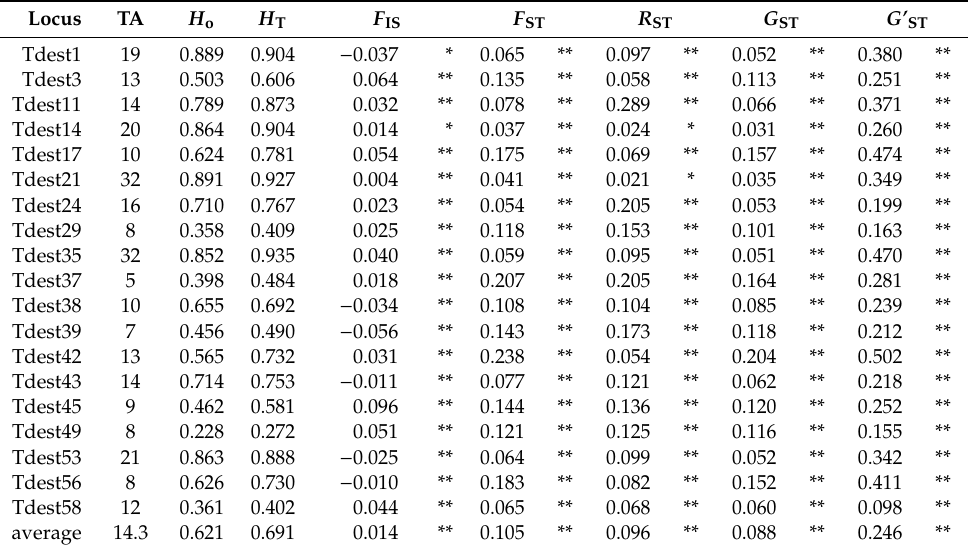
Table A2. Genetic diversity measures estimated at 19 microsatellite